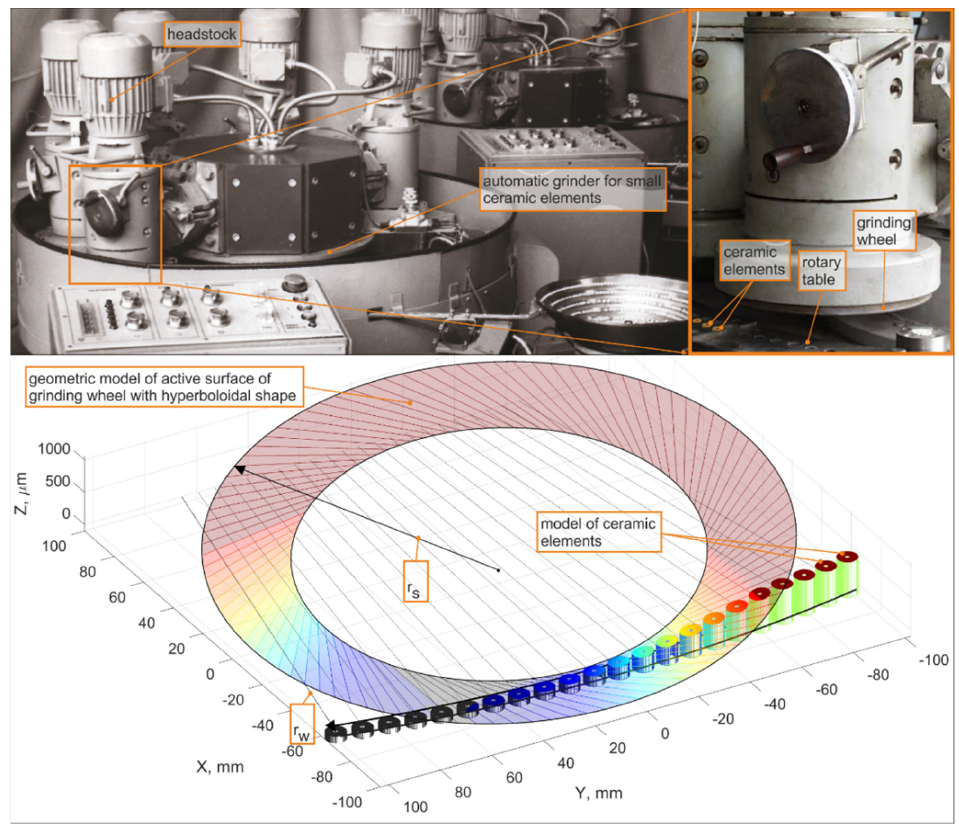
Figure 2. Diagram showing the proposed method of grinding small ceramic elements [6].